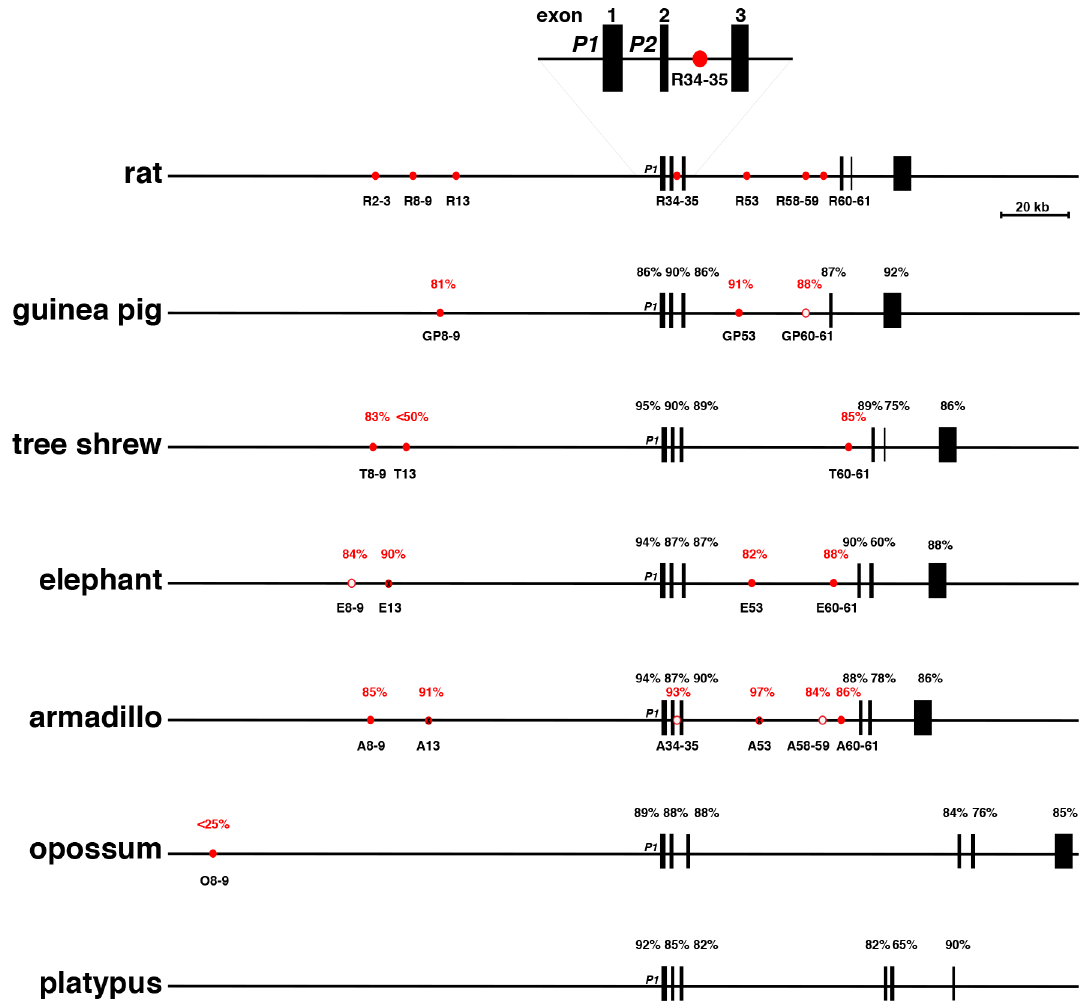
Fig 8. Comparison of additional mammalian IGF1/Igf1 genes and loci. Maps of rat Igf1 , and selectedother IGF1 / Igf1 genesand loci are illustrated. See the legendto Fig 7 for details.